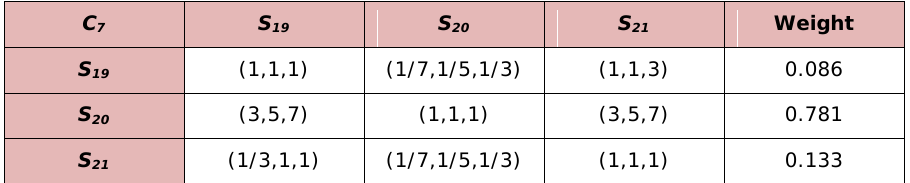
Table 9. “Fuzzy comparison matrix of the sub-criteria with respect to